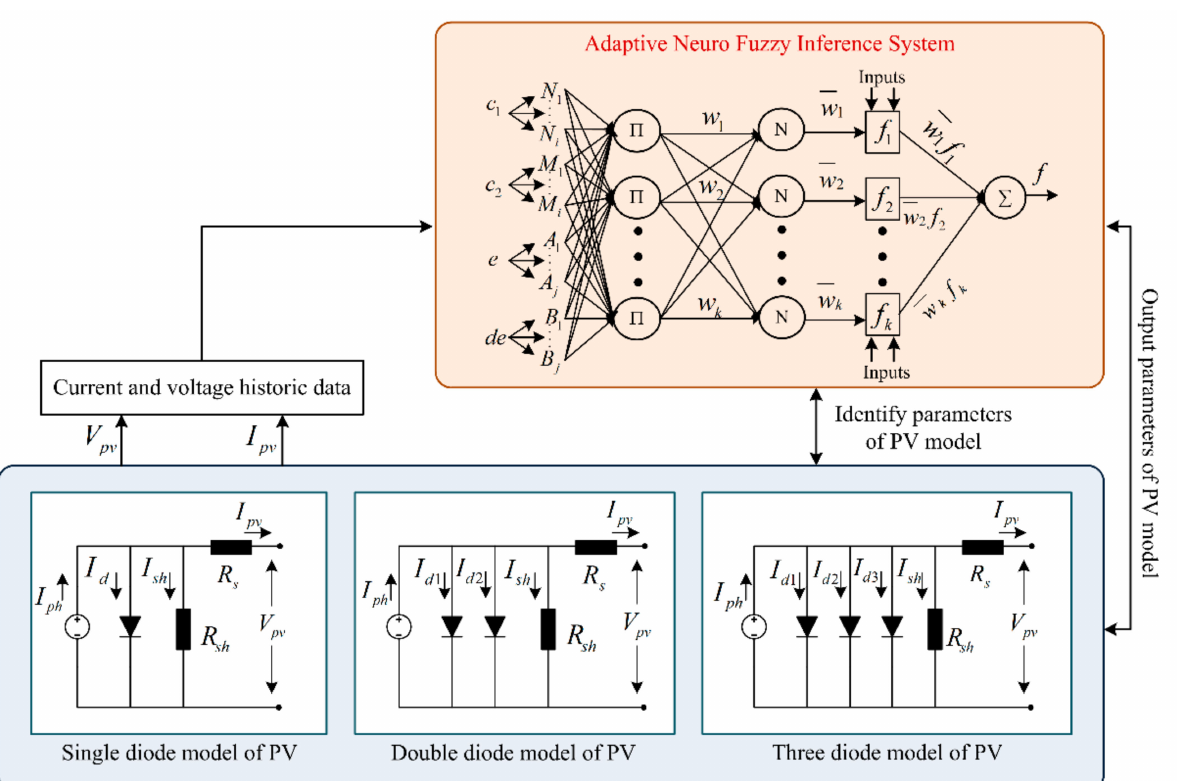
Figure 5. Parameter identification with adaptive neuro fuzzy inference system